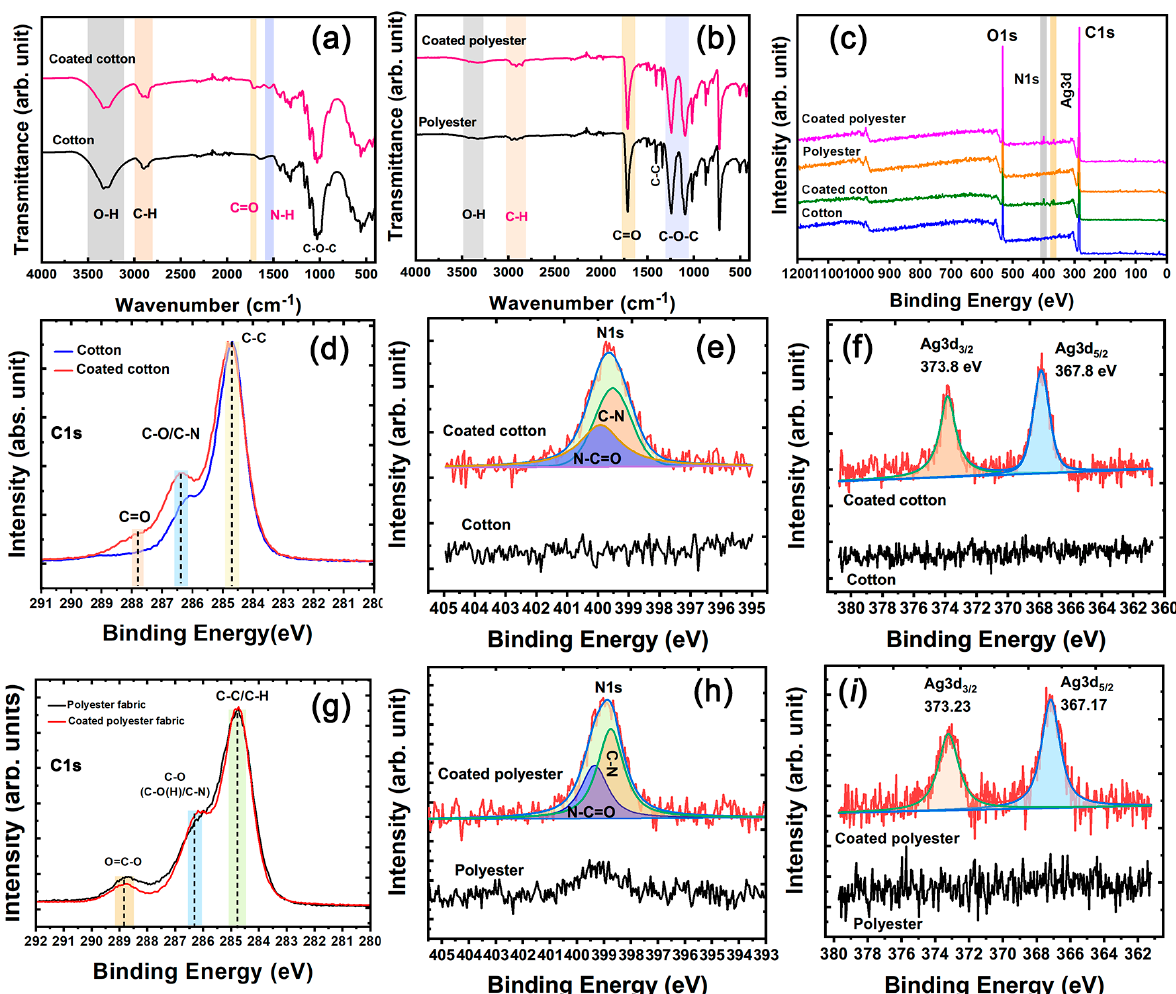
Figure 6. ( a , b ) FTIR spectra and ( c ) Wide-scan, ( d , g ) C1s, ( e , h ) N1s, and ( f , i ) Ag3d XPS spectra of cotton and polyester fabrics. cotton and polyester